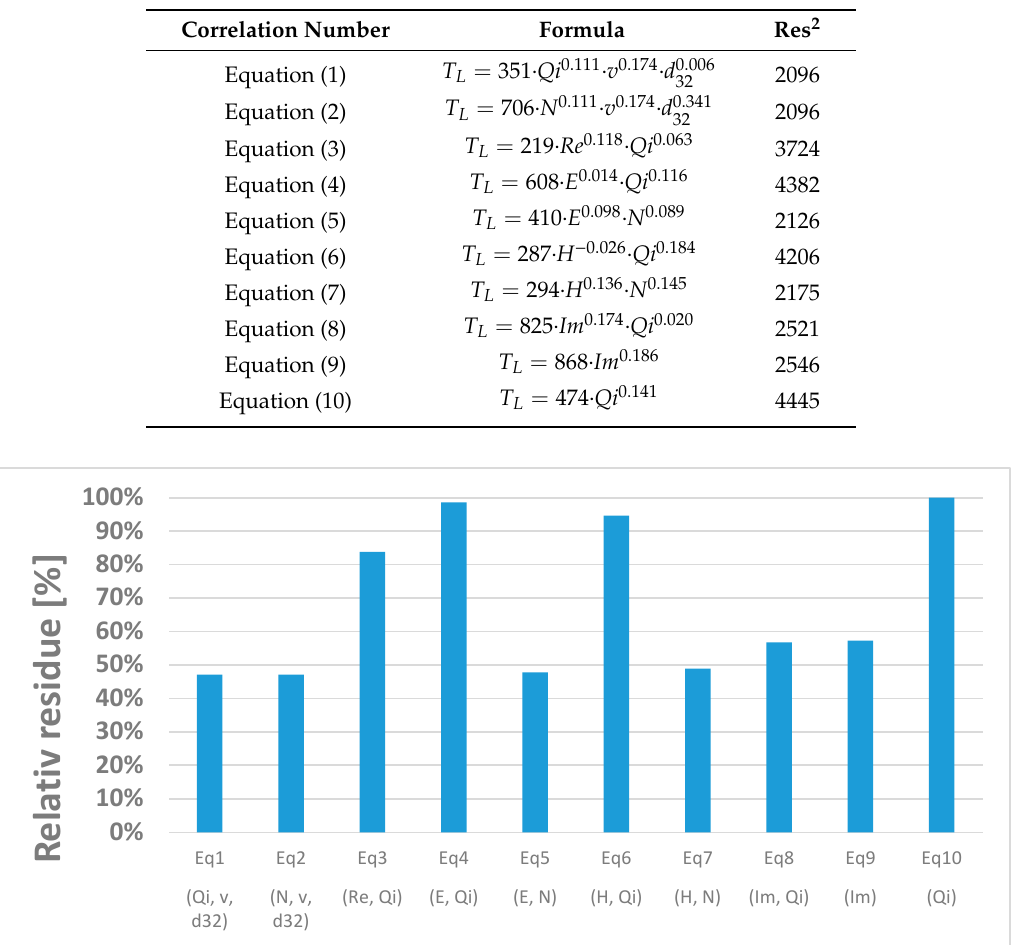
Figure 9. Comparison of Equations (1)–(10) based on relative residue Res 2 . The parameters which were used are written under each column.